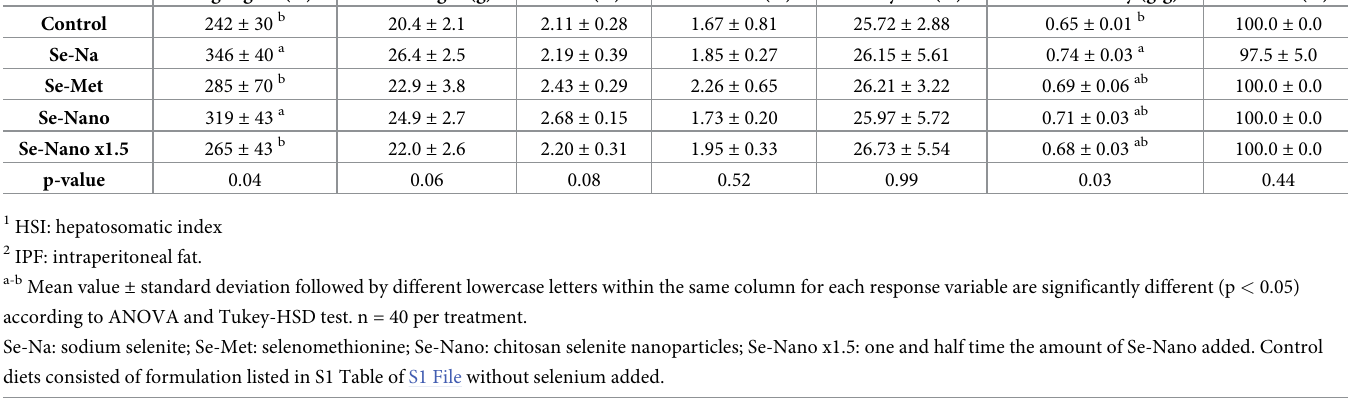
Table 2. Comparison of growth performance indices of different experimental diets fed to Nile tilapia ( Oreochromis niloticus ) fingerlings for 60 days.